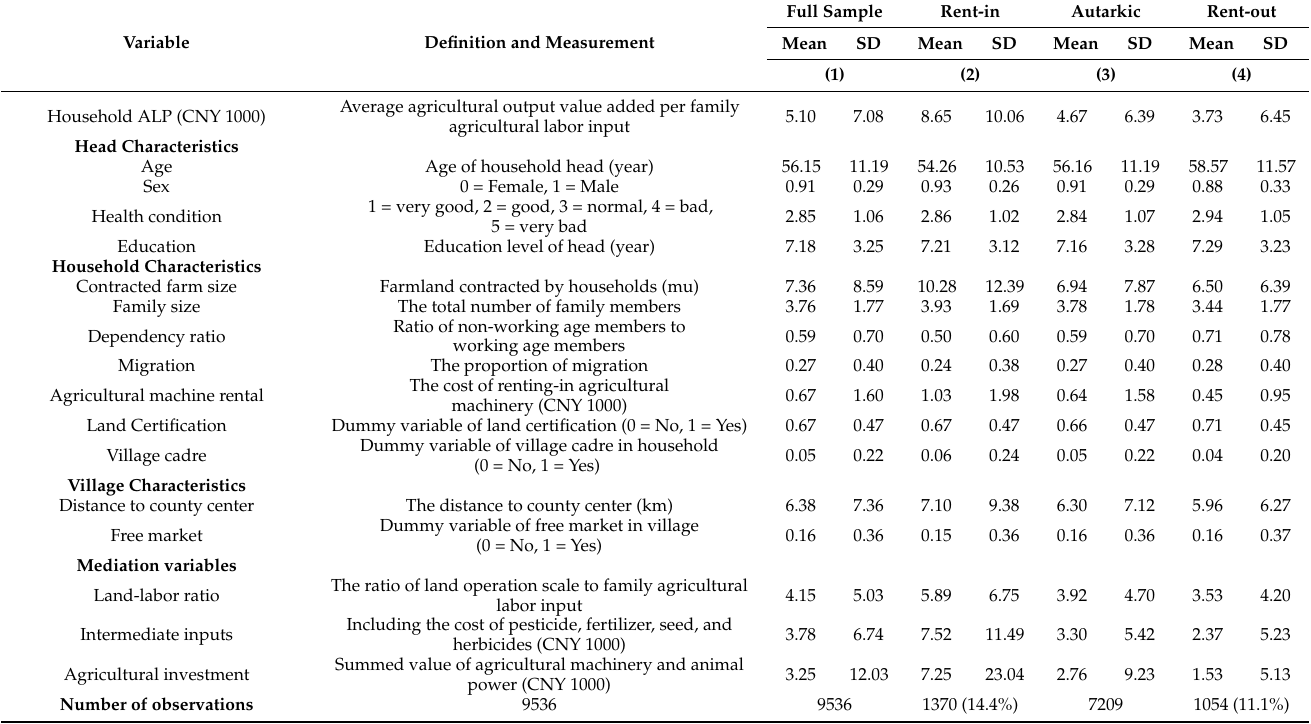
Table 1. Descriptive statistics of key variables Data source: China Household Finance Survey